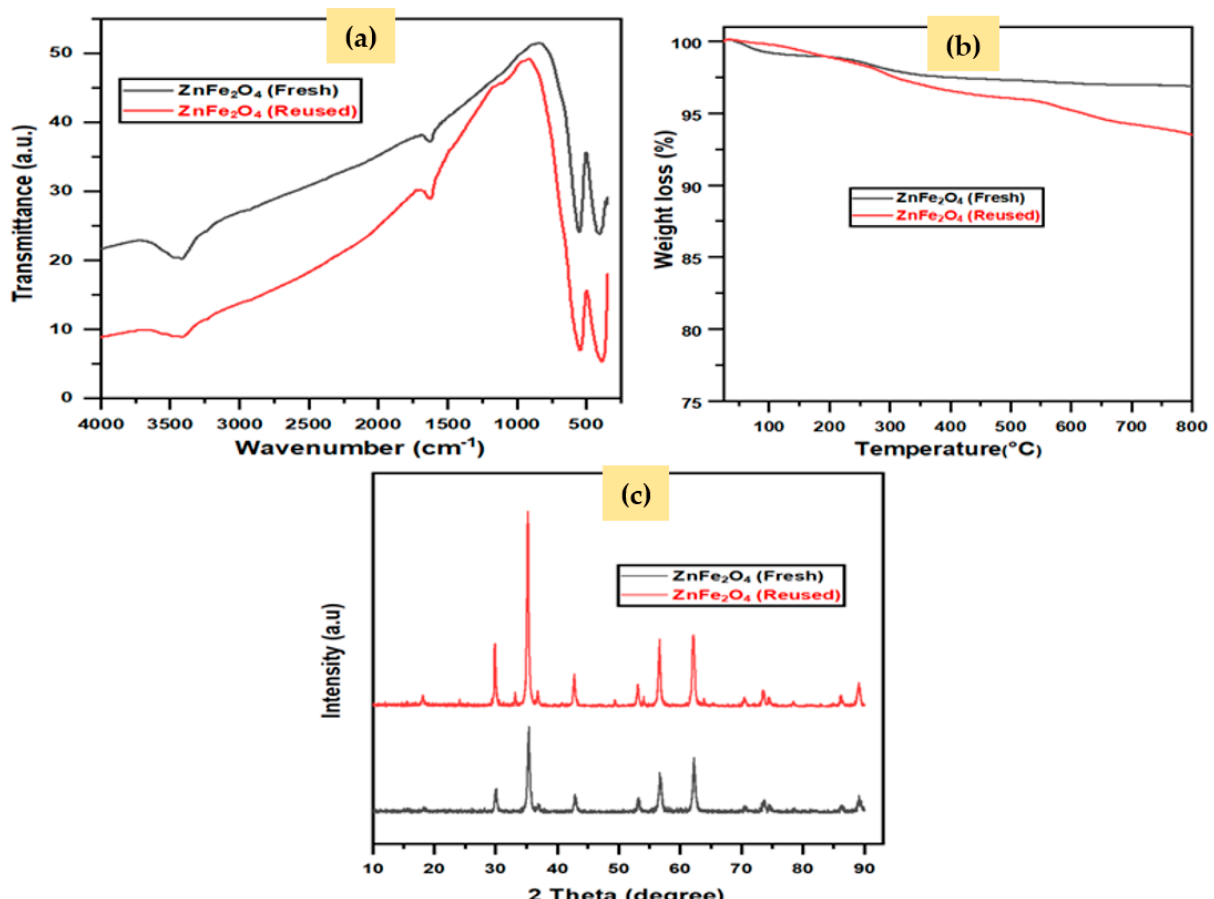
Catalysts 2023 , 13 , x FOR PEER REVIEW Figure 13. The FTIR ( a ), TGA ( b ), and XRD ( c ) for fresh and reused ZFNPs after the catalytic cycle.